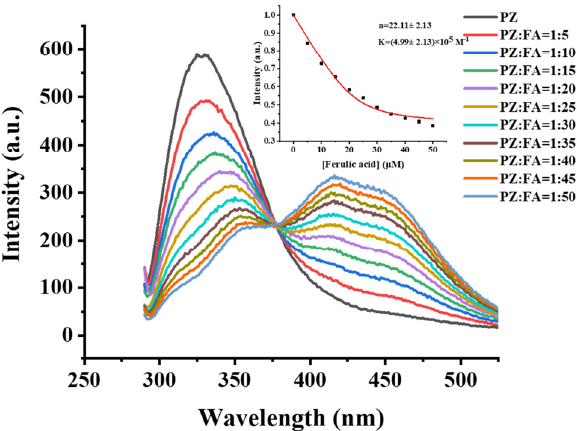
Figure 2. Fluorescence-quenching of PZ (1 µ M) in the presence of FA with various molar ratios. The inset is the fit of Equation (1) to these data with n = 22.11 ± 2.13, K = 4.99 ± 2.13 × 10 5 M − 1 . Conditions: λ Ex = 280 nm, both slits for excitation and emission are 10 nm, 1.0 µ M PZ, 5.0–50.0 µ M FA, 50.0 mM sodium citrate buffer, pH 4.2, and 25 °C.